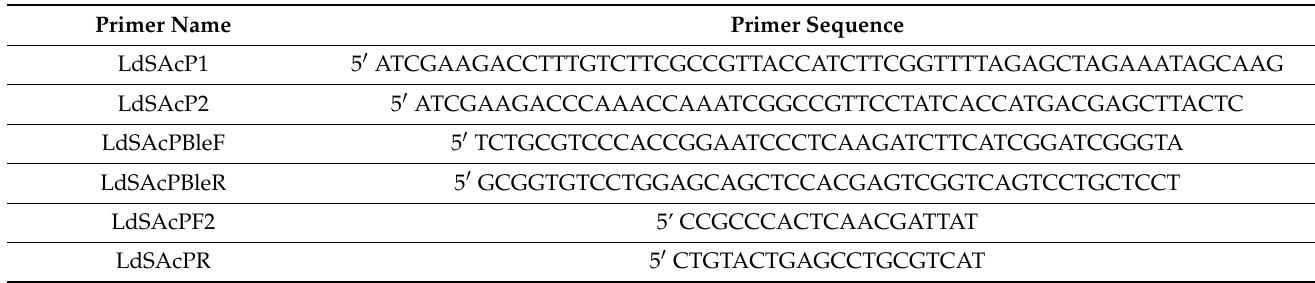
Table 1. Primers and associated